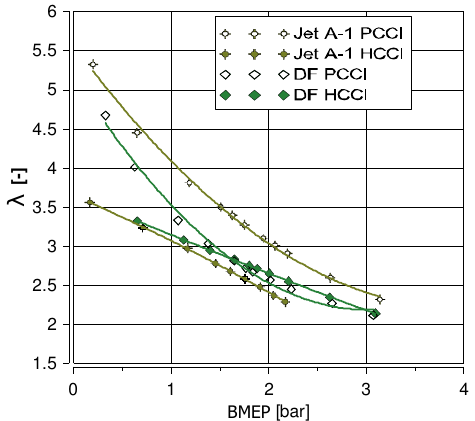
Fig. 7. Total excess air coefficient l vs. BMEP for four modes of fuelling